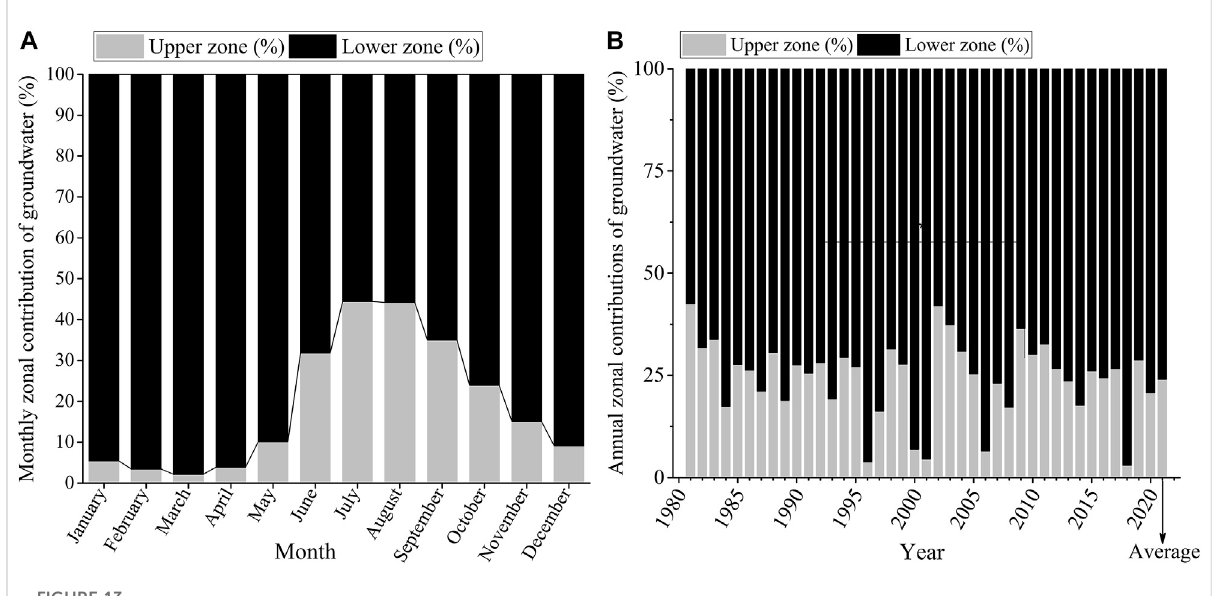
FIGURE 13 Temporalvariationsingroundwatercontributionfromsoilupperanddeepzonetostream fl ows, (A) atmonthlytimescale; (B) attheannualtime